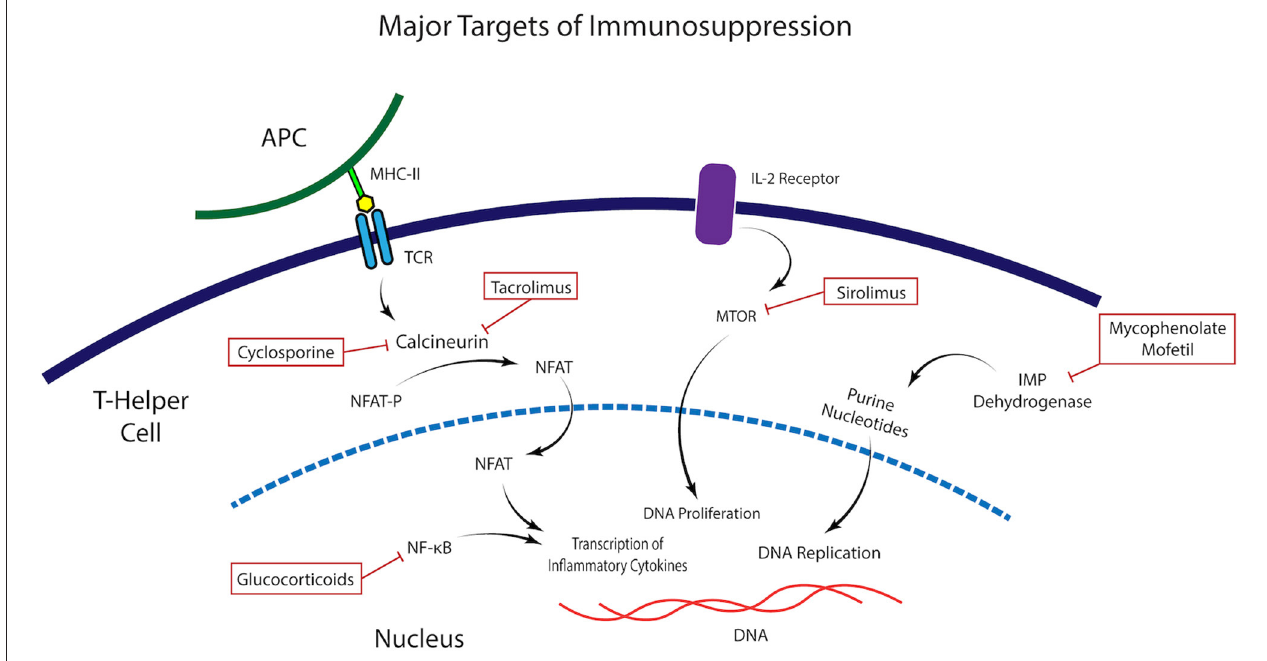
FIGURE 1 | Molecular targets of immunomodulatory medications. Illustration of the mechanism of action and molecular targets of the immunomodulatory agents commonly used in the control of the alloimmune and autoimmune response in Stevens Johnsons